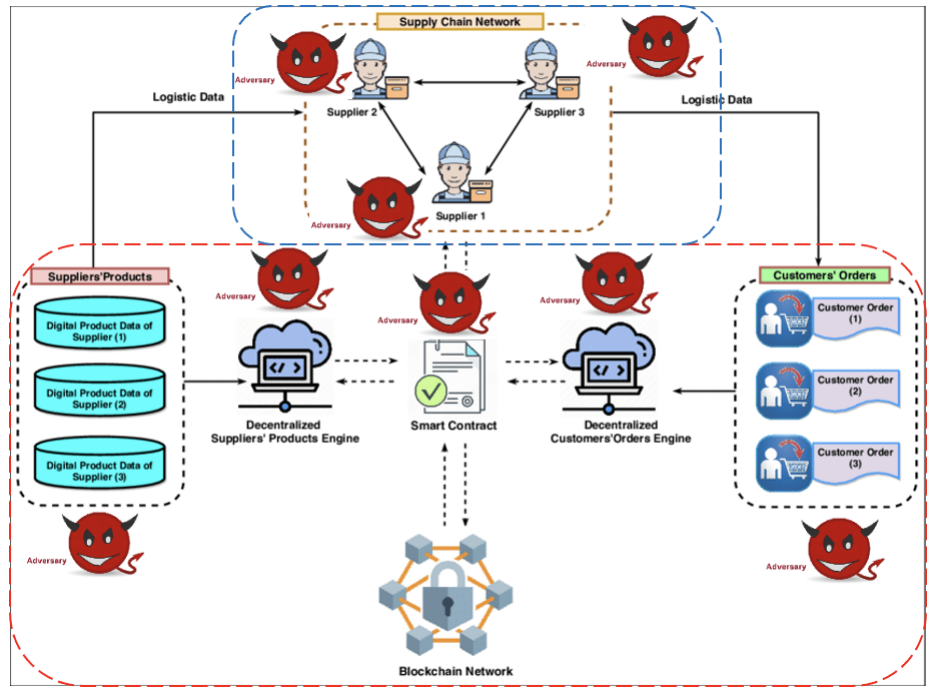
Figure 1. Threat model. Internal threats (red-dotted area): blockchain infrastructure; External threats (blue-dotted area): stakeholder’s